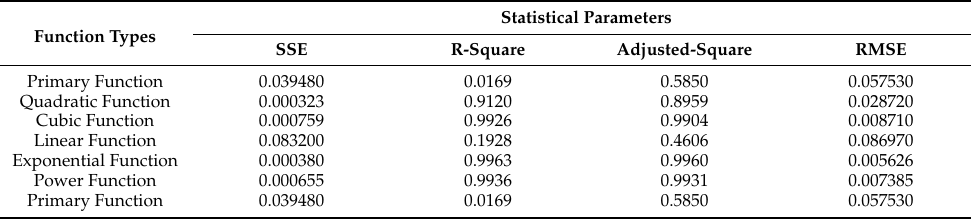
Table 5. Results of ticket-purchasing rates’ curve